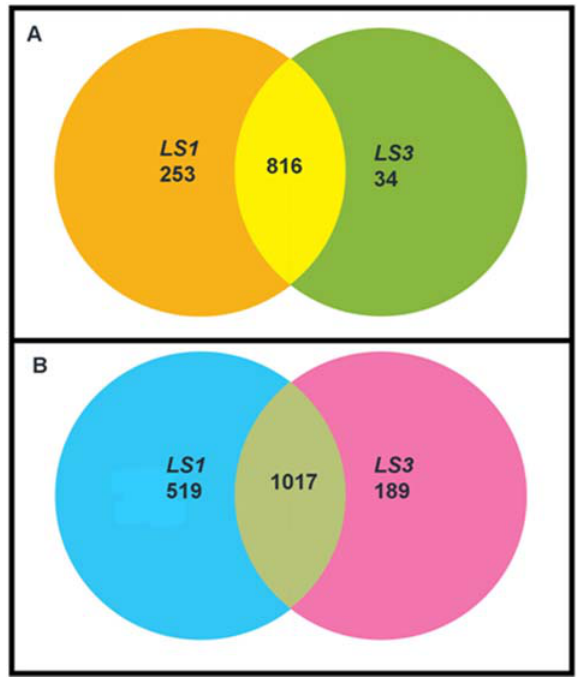
Figure 4. VENN diagram showing the number of cDNAs that exhibit a two-fold change in expression in LS1 and LS3 mutants compared to wild-type plants. The down-regulated cDNAs are diagrammed in Panel A and the up-regulated cDNAs are diagrammed in Panel B. In both diagrams, the area of overlap indicates the number of cDNAs which are similarly regulated in both LS1 and LS3